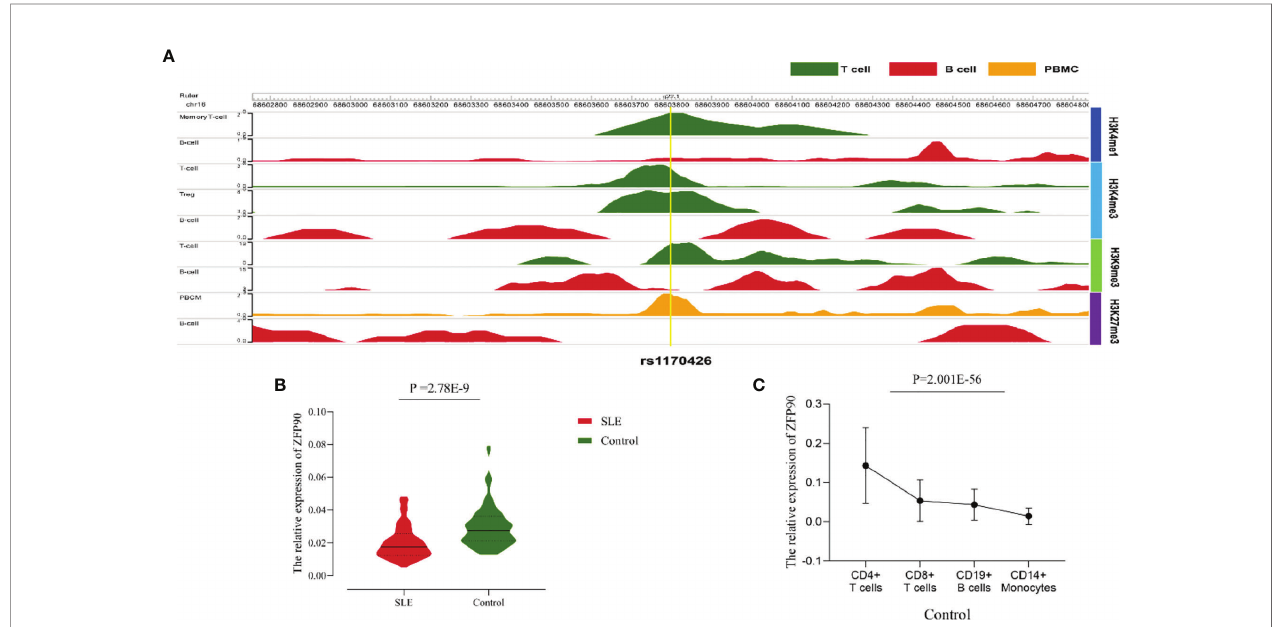
FIGURE 3 | (A) The epigenome annotation results of rs1170426 in T cells (green), B cells (red), and PBMCs (orange). The signal can be found in T cells and PBMCs, while not in B cells. (B) Compared the ZFP90 mRNA expression levels between SLE cases (n = 117, red) and healthy controls (n = 126, green) in PBMCs. The expression levels were lower in cases than in healthy controls ( P =2.78E-9). (C) The ZFP90 mRNA expression levels in four kinds of immune cells were remarkably different ( P = 2.001E-56) and were higher in T